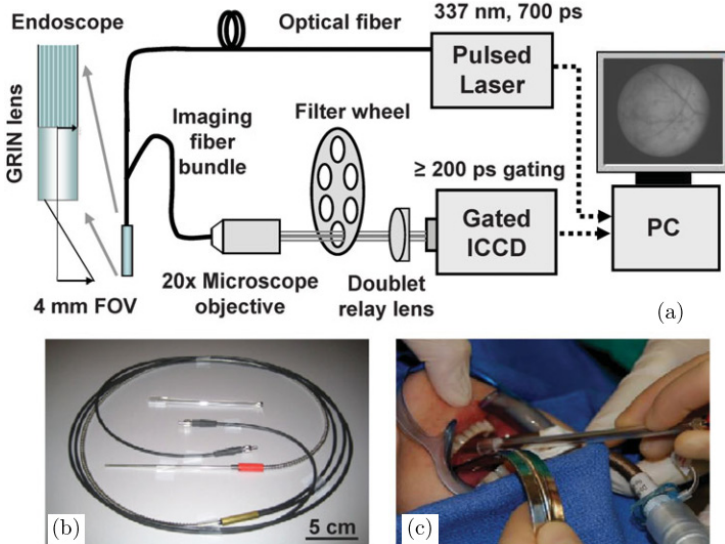
Fig. 10. Fluorescence lifetime microscopic imaging system for monitoring oral cancer. (a) Schematic diagram of FLIM endoscope, GRIN: gradient refractive index, FOV: ¯eld of view, ICCD: intensi¯ed charge-coupled device, PC: personal computer, (b) Semi °exible endoscope for surgery, (c) FLIM probe for oral cavity. 42 (Permission has been granted by \Cambridge University Press" through Copyright Clearance Center's RightsLink r service.)